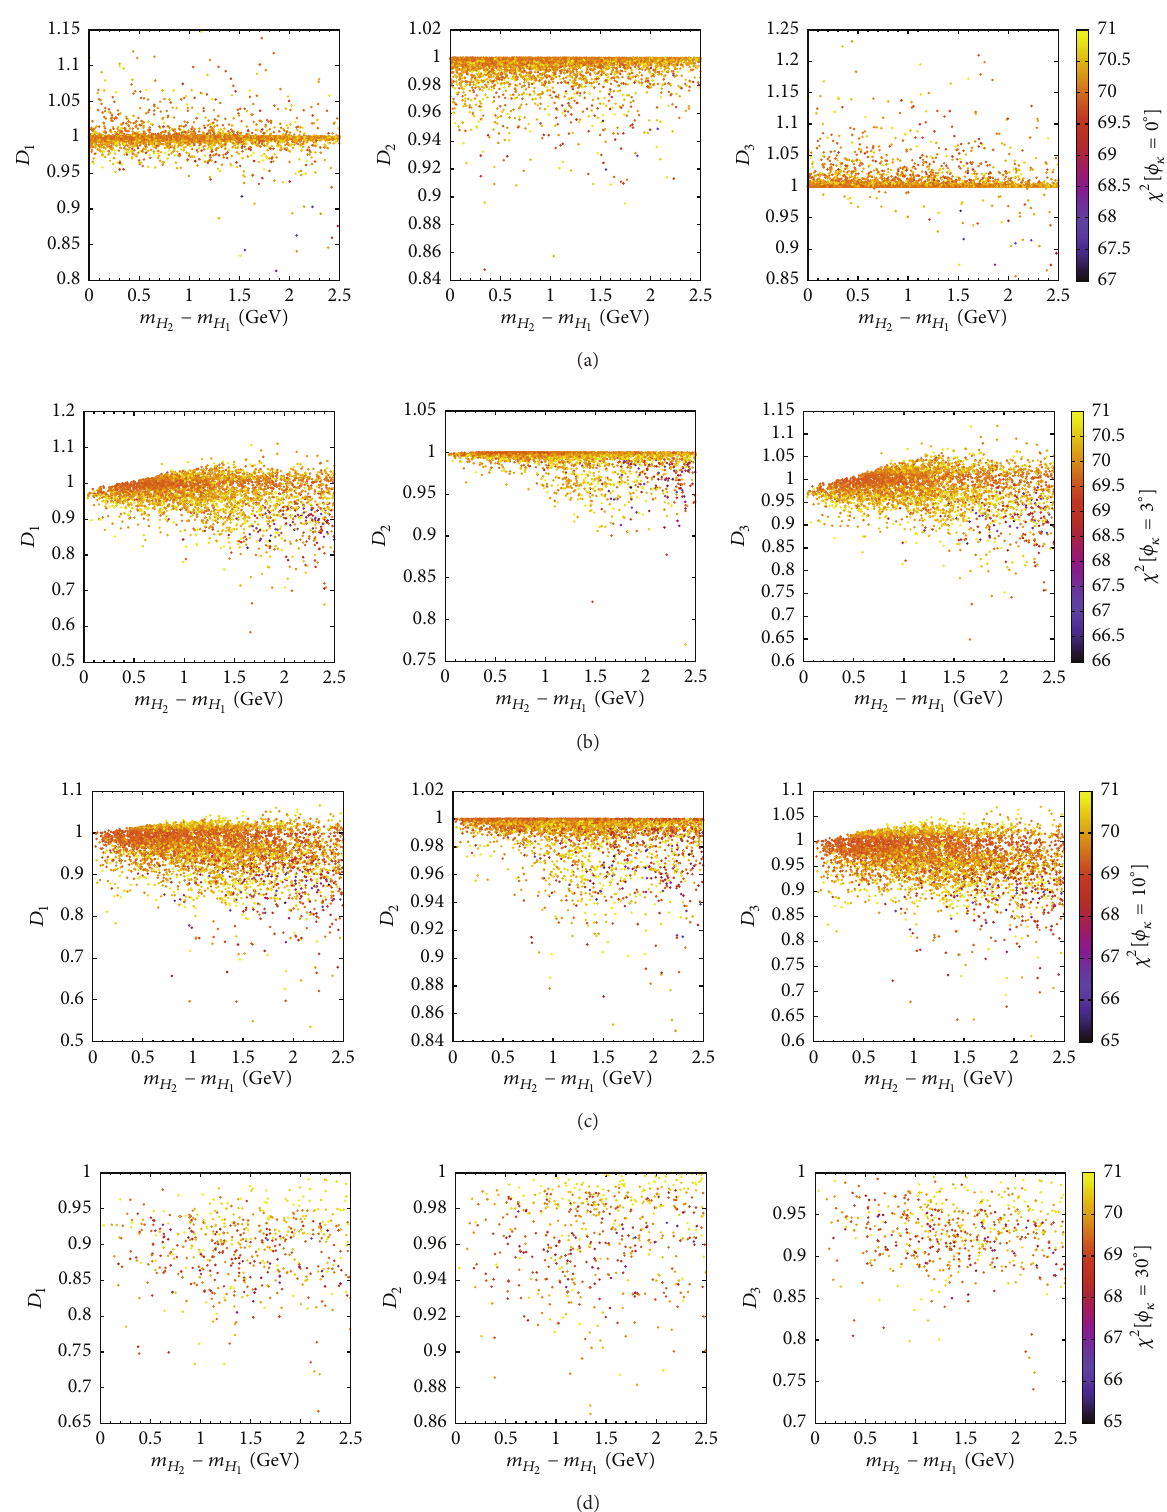
Figure 2: The ratios 𝐷 1 , 𝐷 2 , and 𝐷 3 , defined in (11), as functions of the difference between 𝐻 2 and 𝐻 1 masses, in the scenario when 𝐻 obs = + 𝐻 𝜙 0 ∘ , in (b) to 3 ∘ , in (c) to 10 ∘ , and in (d) to 30 ∘ . The heat map in all the panels corresponds to the total 𝜒 2 𝐻 1 2 . In (a) 𝜅 is set to